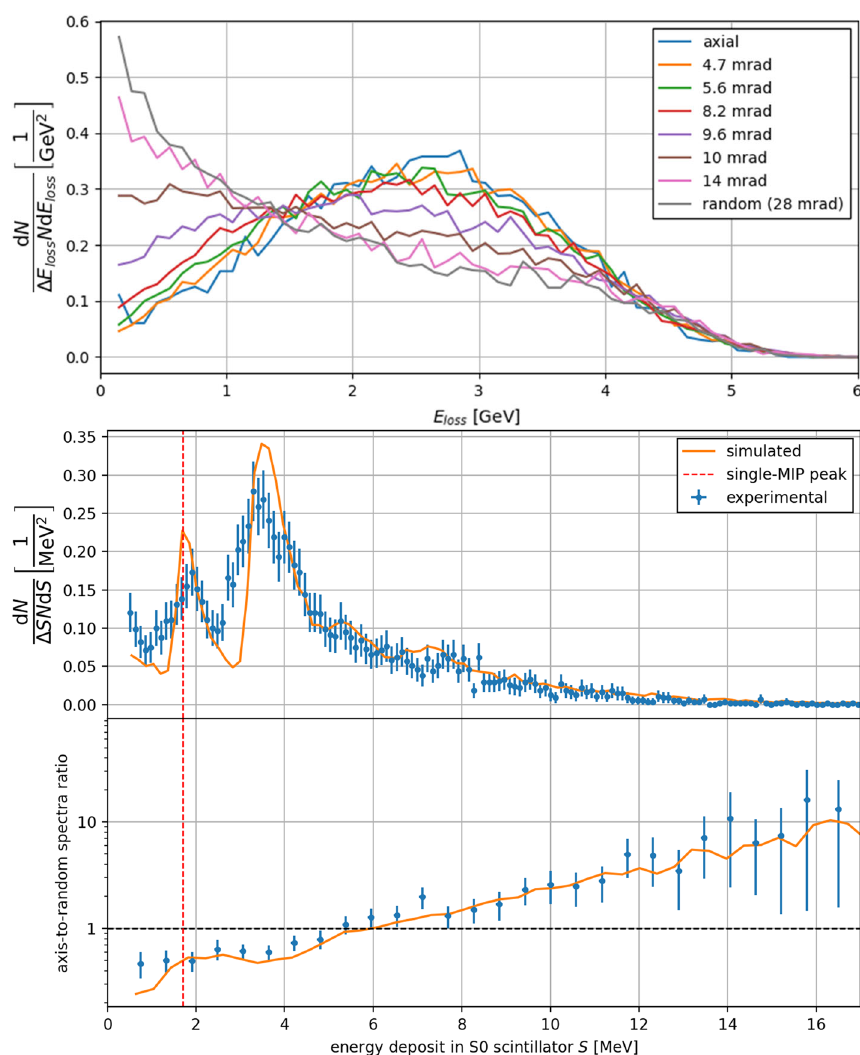
Fig. 7 Comparison between experimental spectra of E loss at various angular configurations